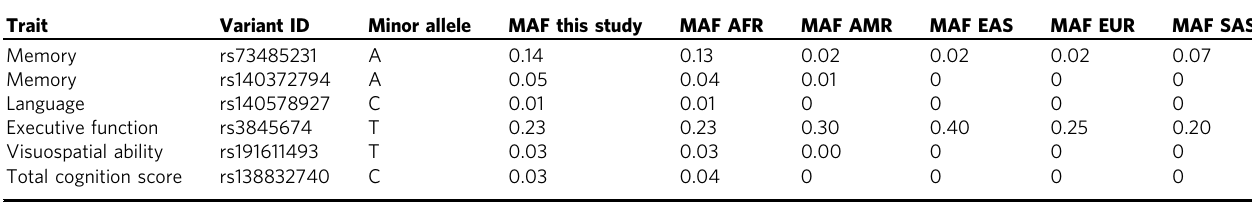
Table 2 Minor allele frequency distribution of reported association signals in our sample compared to 1000 genomes super